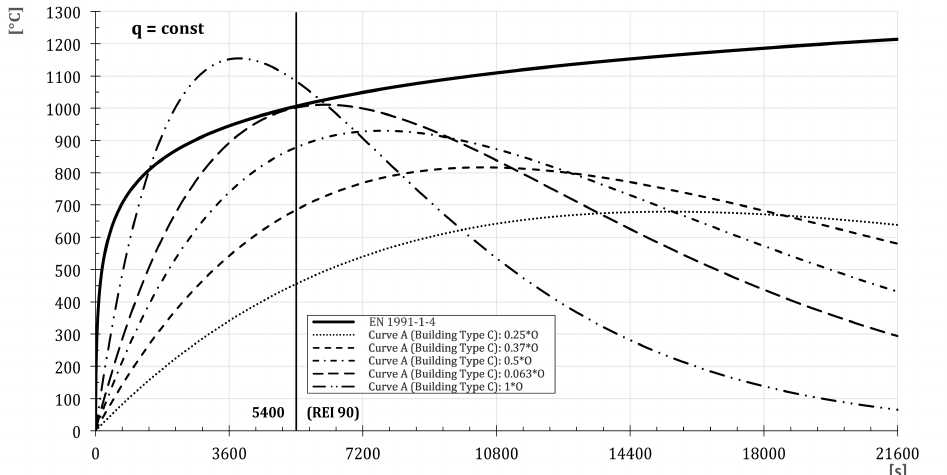
Figure 3. Trend of the temperatures with respect to time (q = 233.6 MJ m − 2 ; O = 0.0289 m 0.5 ) based on the prescriptive approach (EN 1991-1-2) and the simplified performance-based approach (Equation (3): “Curve A with a building of Type C”) changing with the opening factor